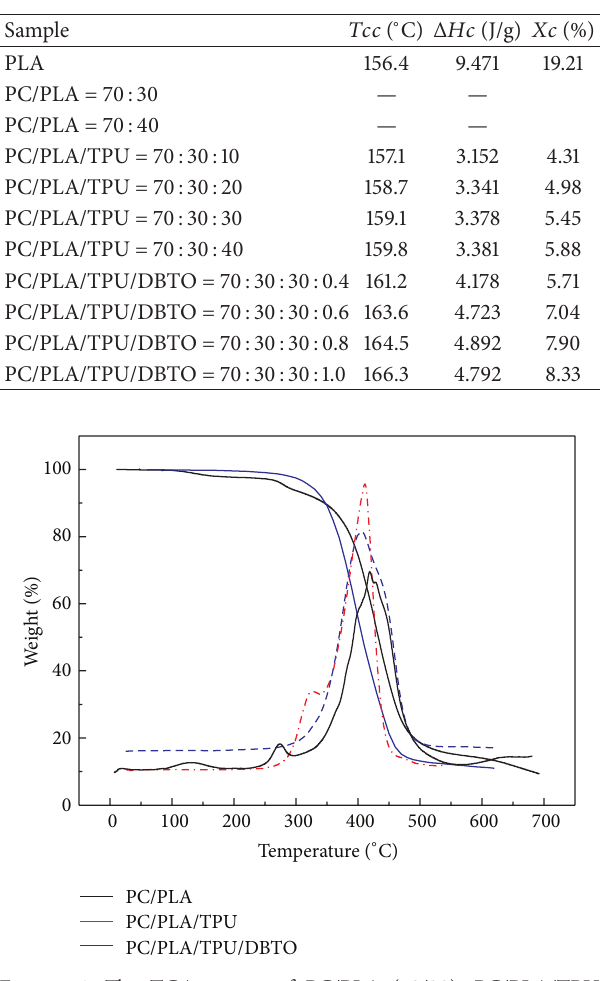
Figure 4: The TGA curves of PC/PLA (70/30), PC/PLA/TPU (70/30/30), and PC/PLA/TPU/DBTO (70/30/30/0.8) blends. The full line: thermogravimetric curve; dash line: derivative thermo- gravimetry